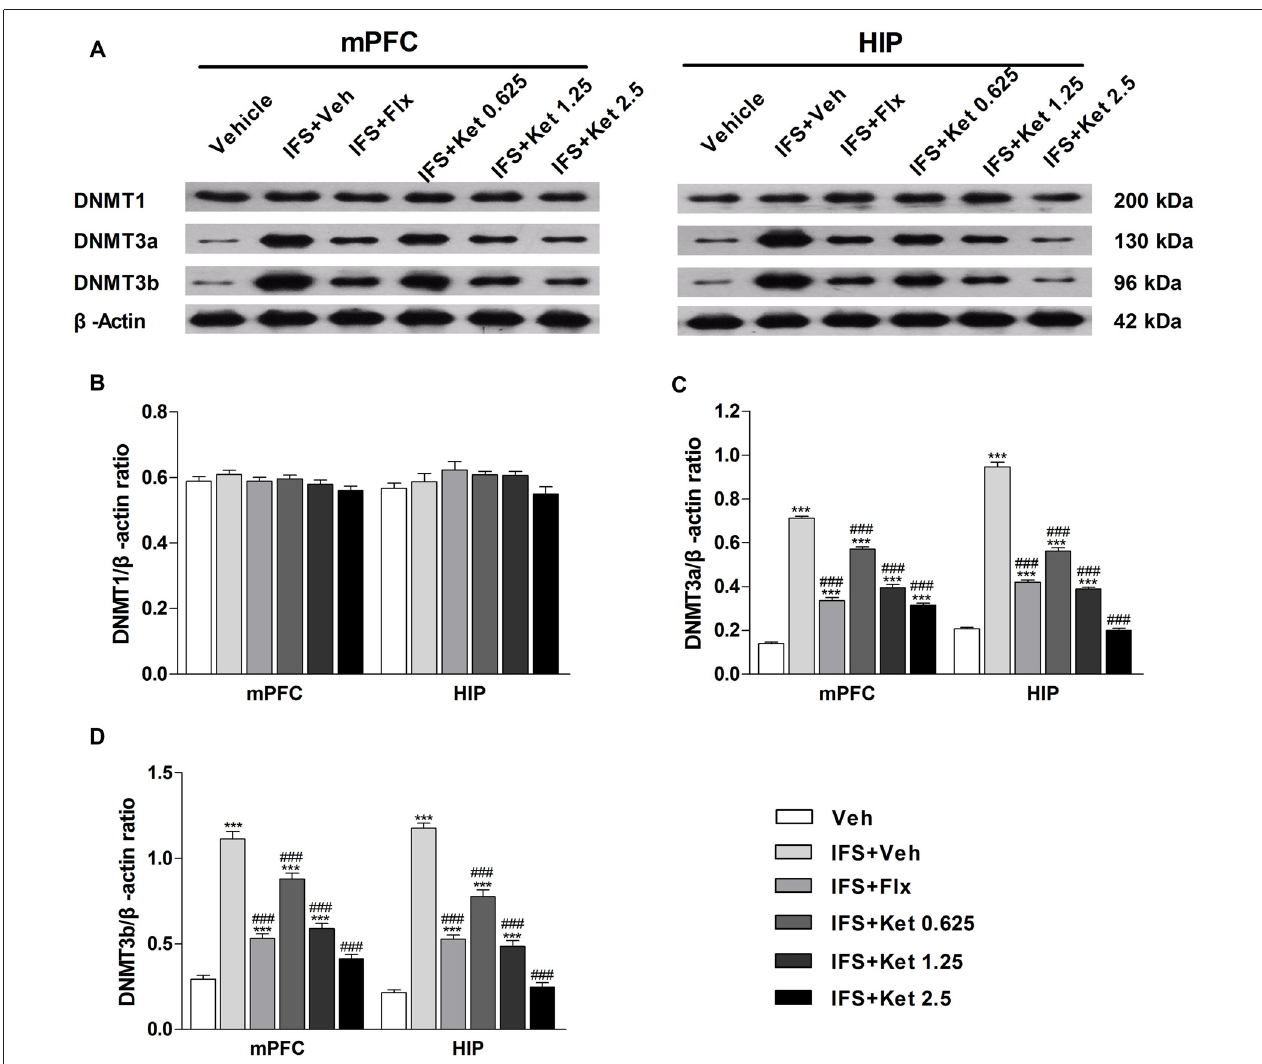
FIGURE 6 | Effects of ketamine on the levels of DNA methyltransferases (DNMTs) in the medial prefrontal cortex (mPFC) and hippocampus (HIP) of IFS mice. (A) Representative blots of the protein levels in the six groups. (B) The DNMT1 had no significant difference among the six groups. (C,D) IFS led to the overexpression of DNMT3a and DNMT3b in the mPFC and HIP. Data are presented as mean ± SEM ( n = 5 in per group). ∗∗∗ P < 0.001 compared with the Veh group; ### P < 0.001 compared with the IFS + Veh